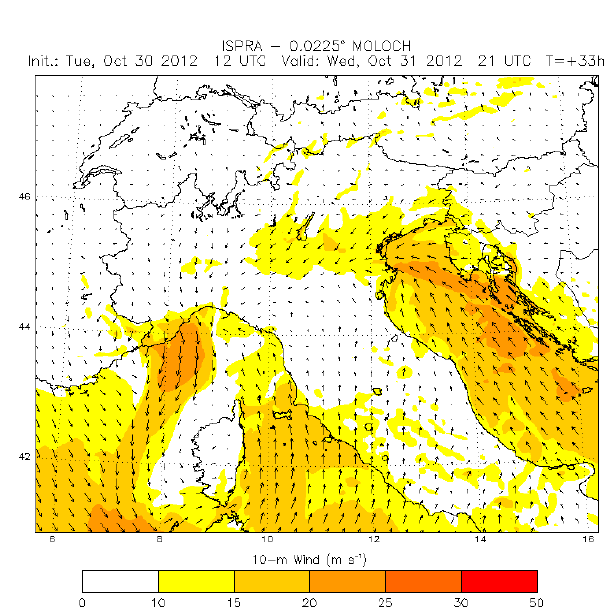
Figure 8. Test-case 1: comparison between forecast and buoy data at Ancona location.